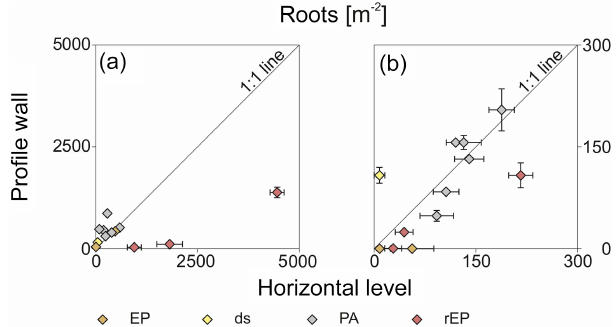
Figure 7. Comparison of (a) fine- and (b) medium-root quantities determined at the profile wall at the right side of the soil pit, and those determined on horizontal